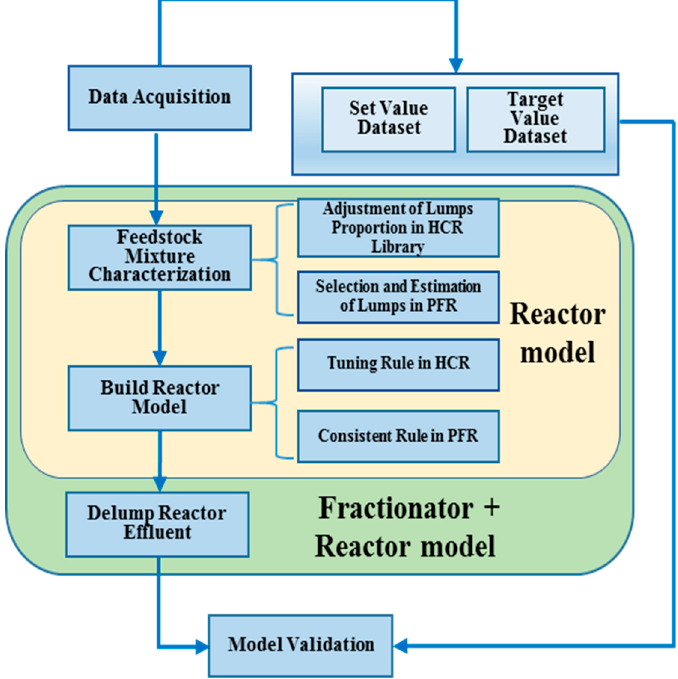
Figure 5. Workflow of building an integrated residue hydrogenation process model.